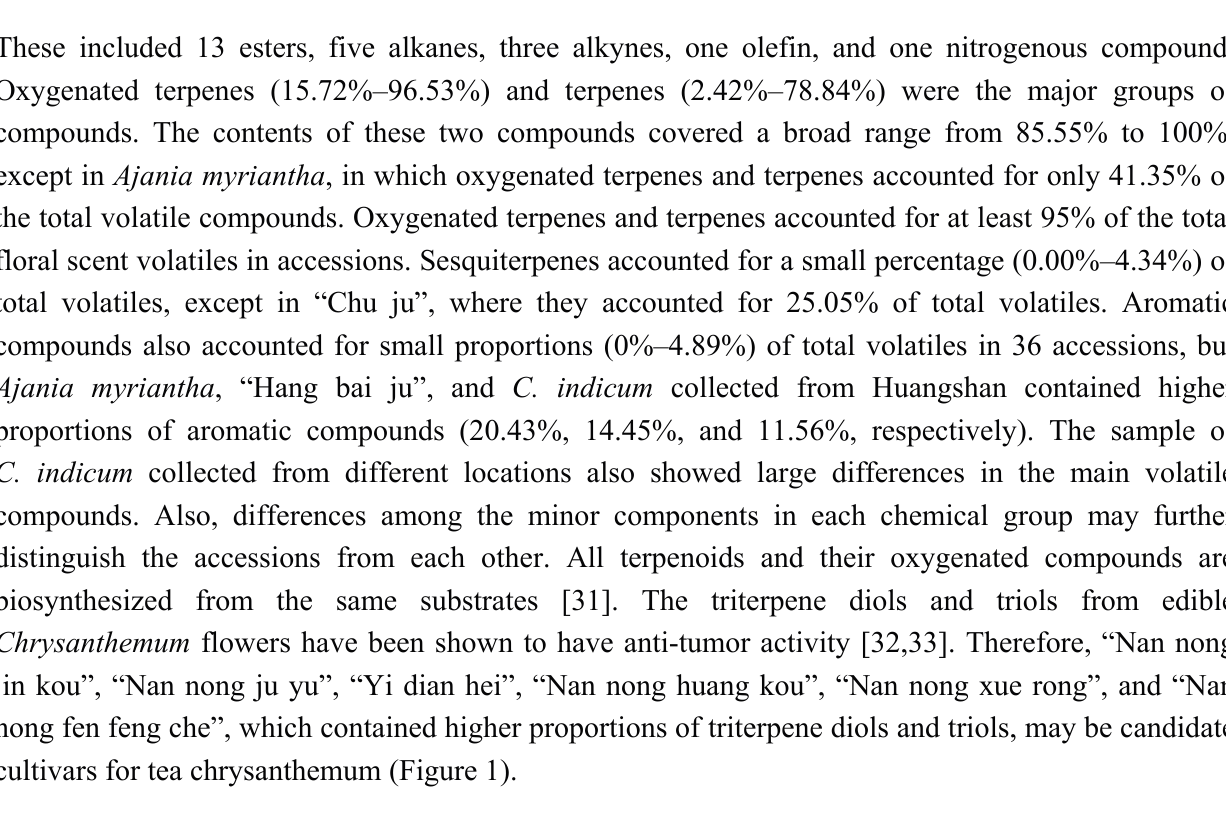
Table 2. Quantity of floral aroma volatiles in 39 accessions of Chrysanthemum